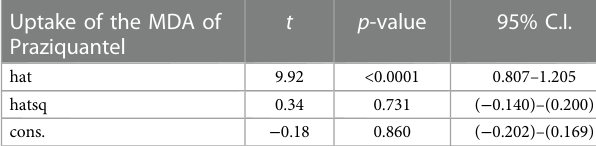
TABLE 3 Model speci fi cation of the full model. TABLE 4 Model speci fi cation of the nested